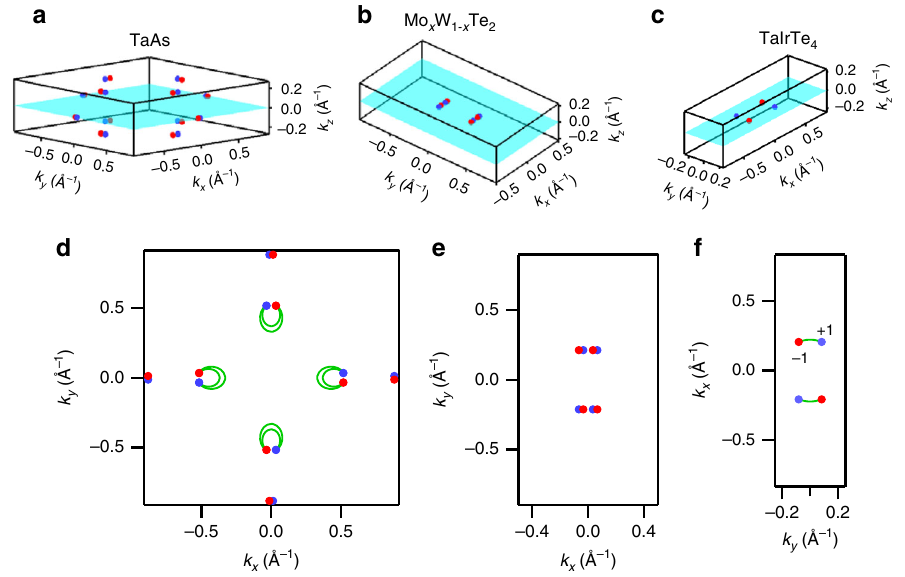
Fig. 4 Comparison of Weyl point con fi gurations. Weyl points, plotted in red and blue for opposite chiralities, for a TaAs, with 24 Weyl points, b Mo x W 1 − x Te 2 , with eight Weyl points and c TaIrTe 4 , with the minimal number, only four Weyl points, making TaIrTe 4 a minimal k z = 0 plane is marked in cyan . d – f The projection of the Weyl points on the (001) surface, with topological Fermi arcs. Note that the Weyl points are plotted numerically, while the Fermi arcs are rough cartoons drawn based on ARPES measurements and ab initio results. The black frame marks the fi rst Brillouin zone. The length of the Fermi arcs in TaIrTe 4 is longer as a fraction of the Brillouin zone as compared to TaAs and Mo x W 1 − x Te Fig. 2h. We also indicate the locations of the E B − k x cuts of Fig. 2